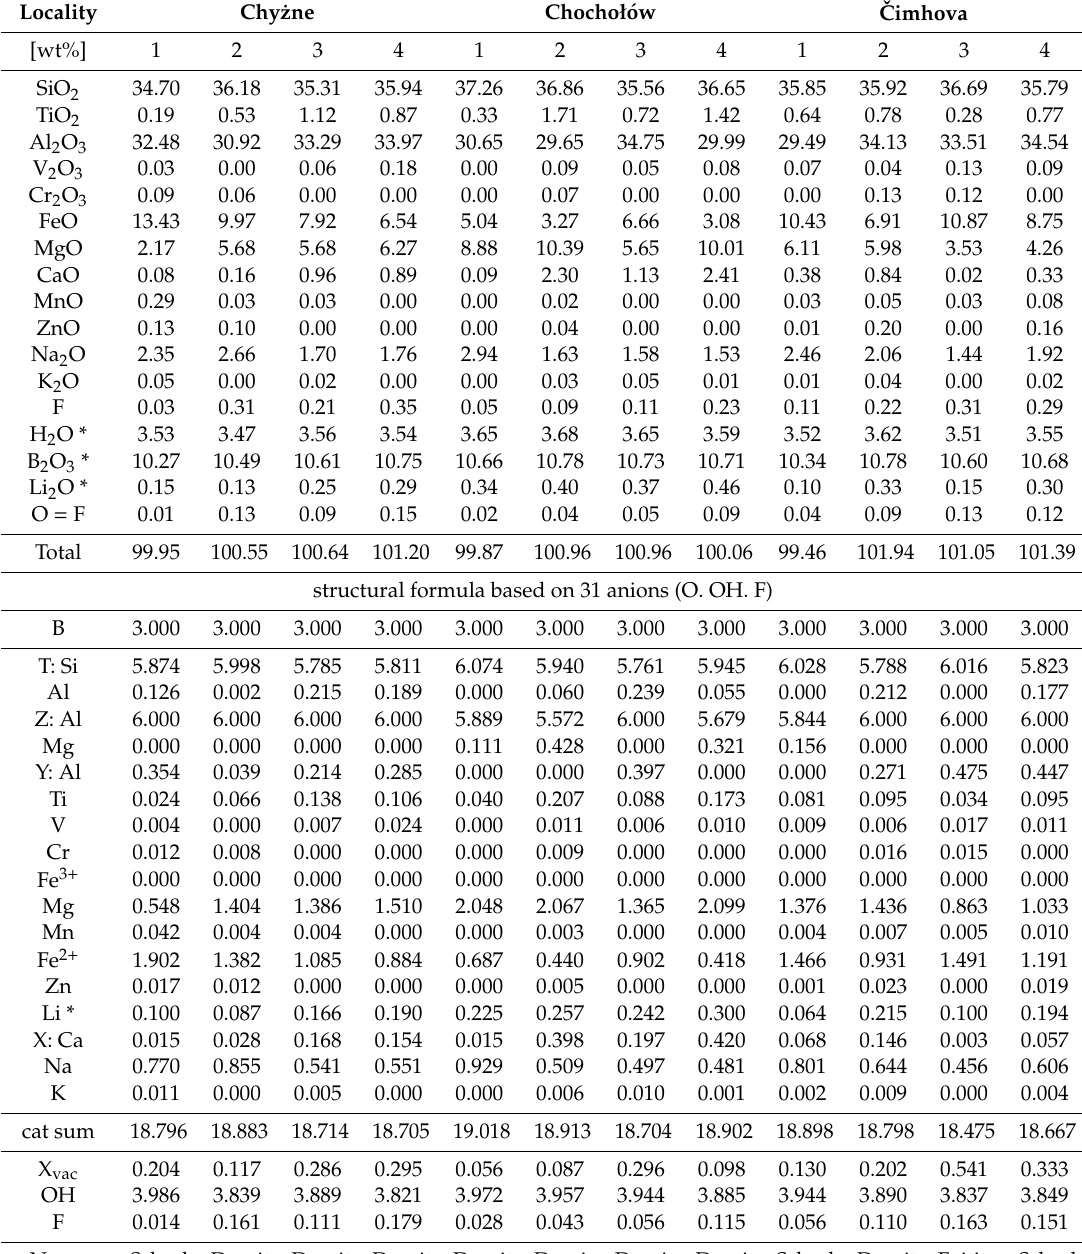
Table 4. Representative analyses of tourmaline from the studied